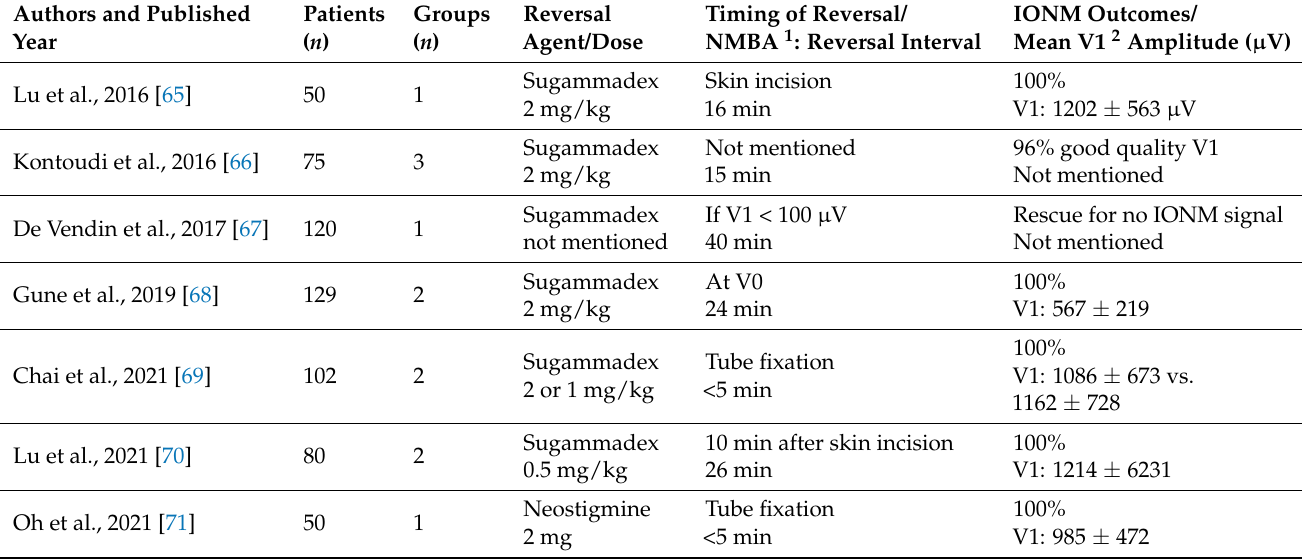
Table 2. Clinical trials investigating the effect of reversal agents on IONM during thyroid